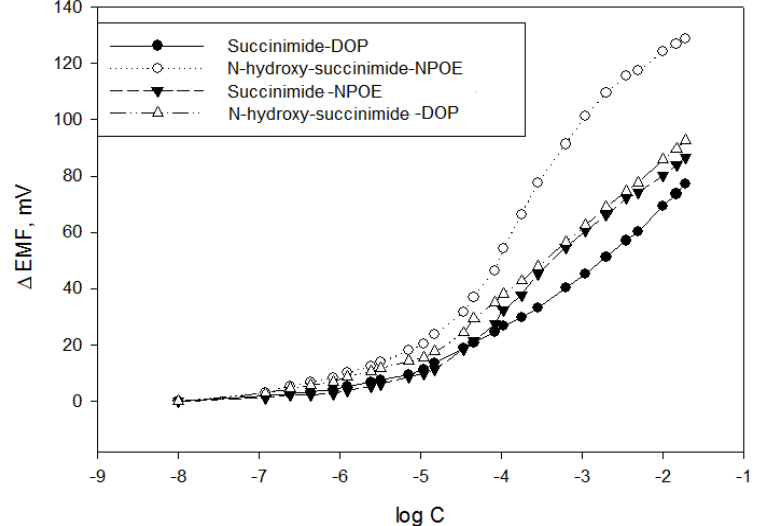
Figure 1. Potential response toward Cu(II) ions of the electrodes with the four potentiometric membranes evaluated.